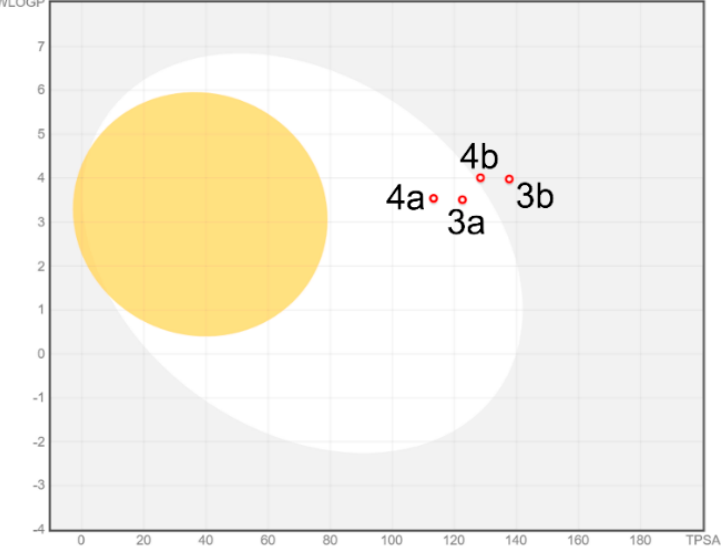
Figure 5. BOILED-Egg diagram for all compounds (lipophilicity (WLOGP) and polarity (tPSA), human intestinal absorption, white area; and blood–brain barrier permeation, yellow area.